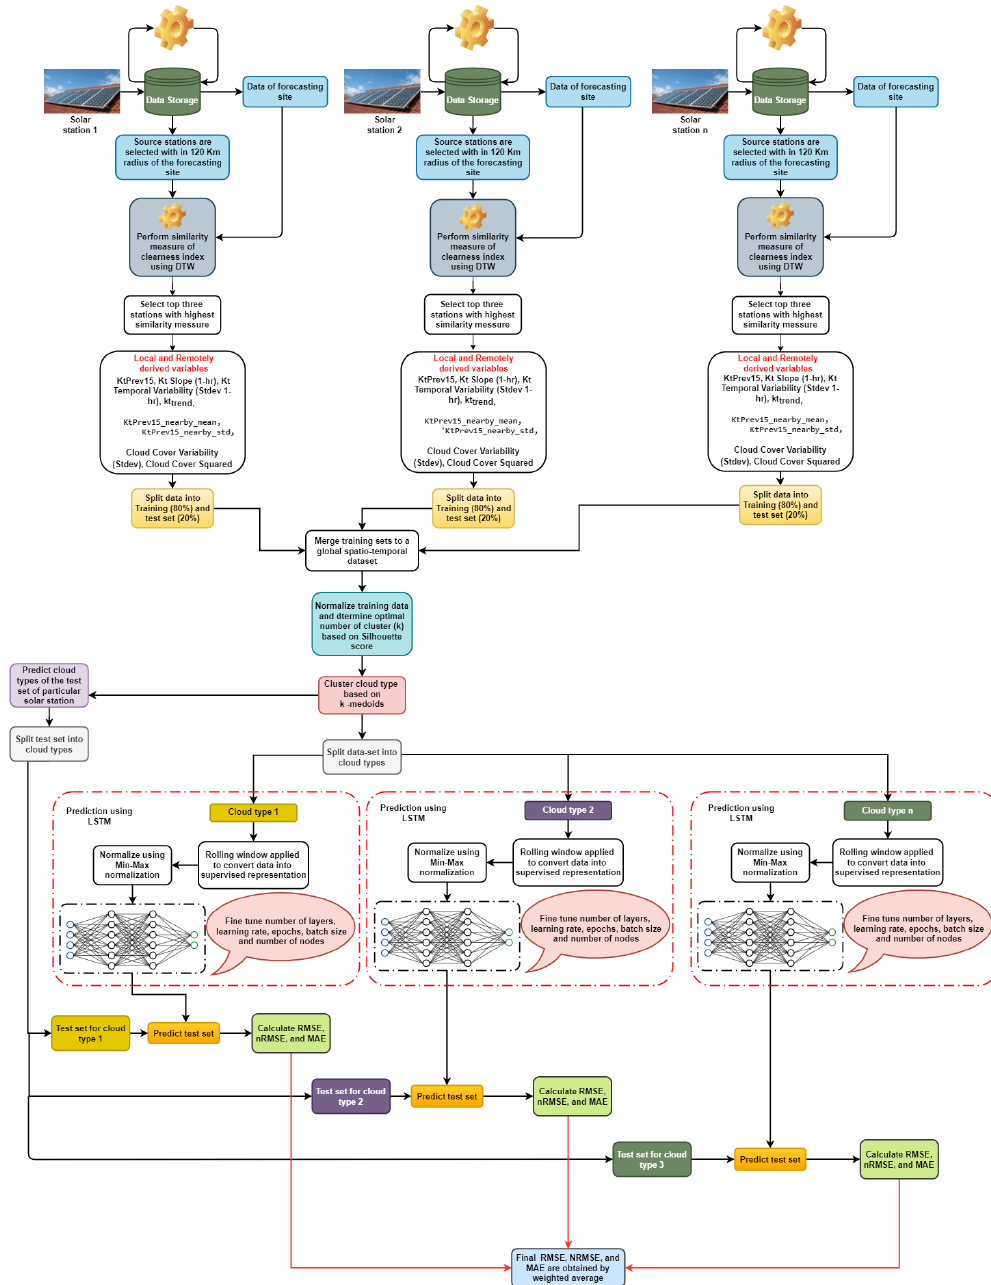
Figure 7. Architecture of clustering-based forecasting model.